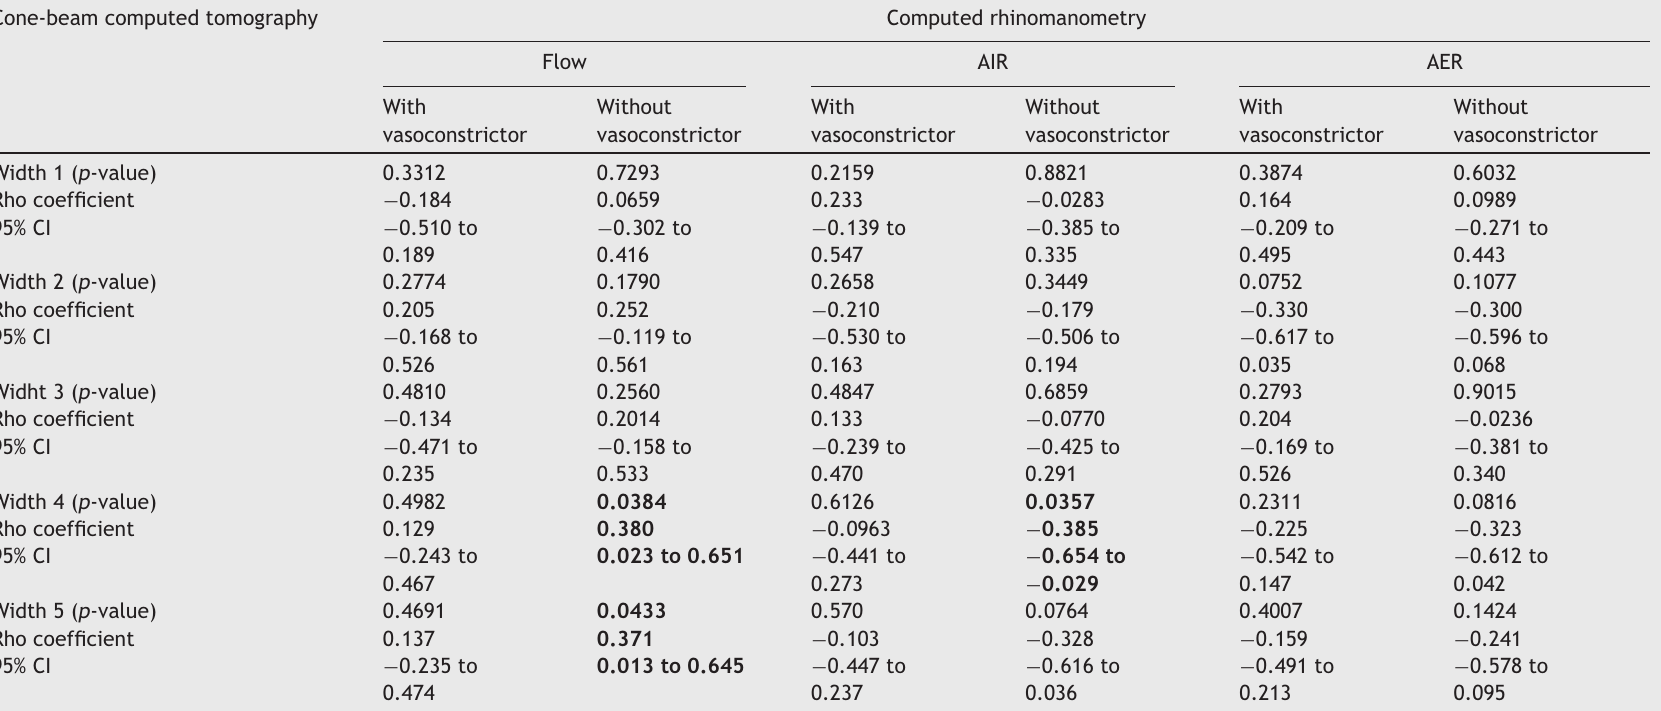
Table 3 Correlation between data of cone-beam computed tomography and computed rhinomanometry in mouth breathers with transverse maxillary deficiency. Cone-beam computed tomography Computed